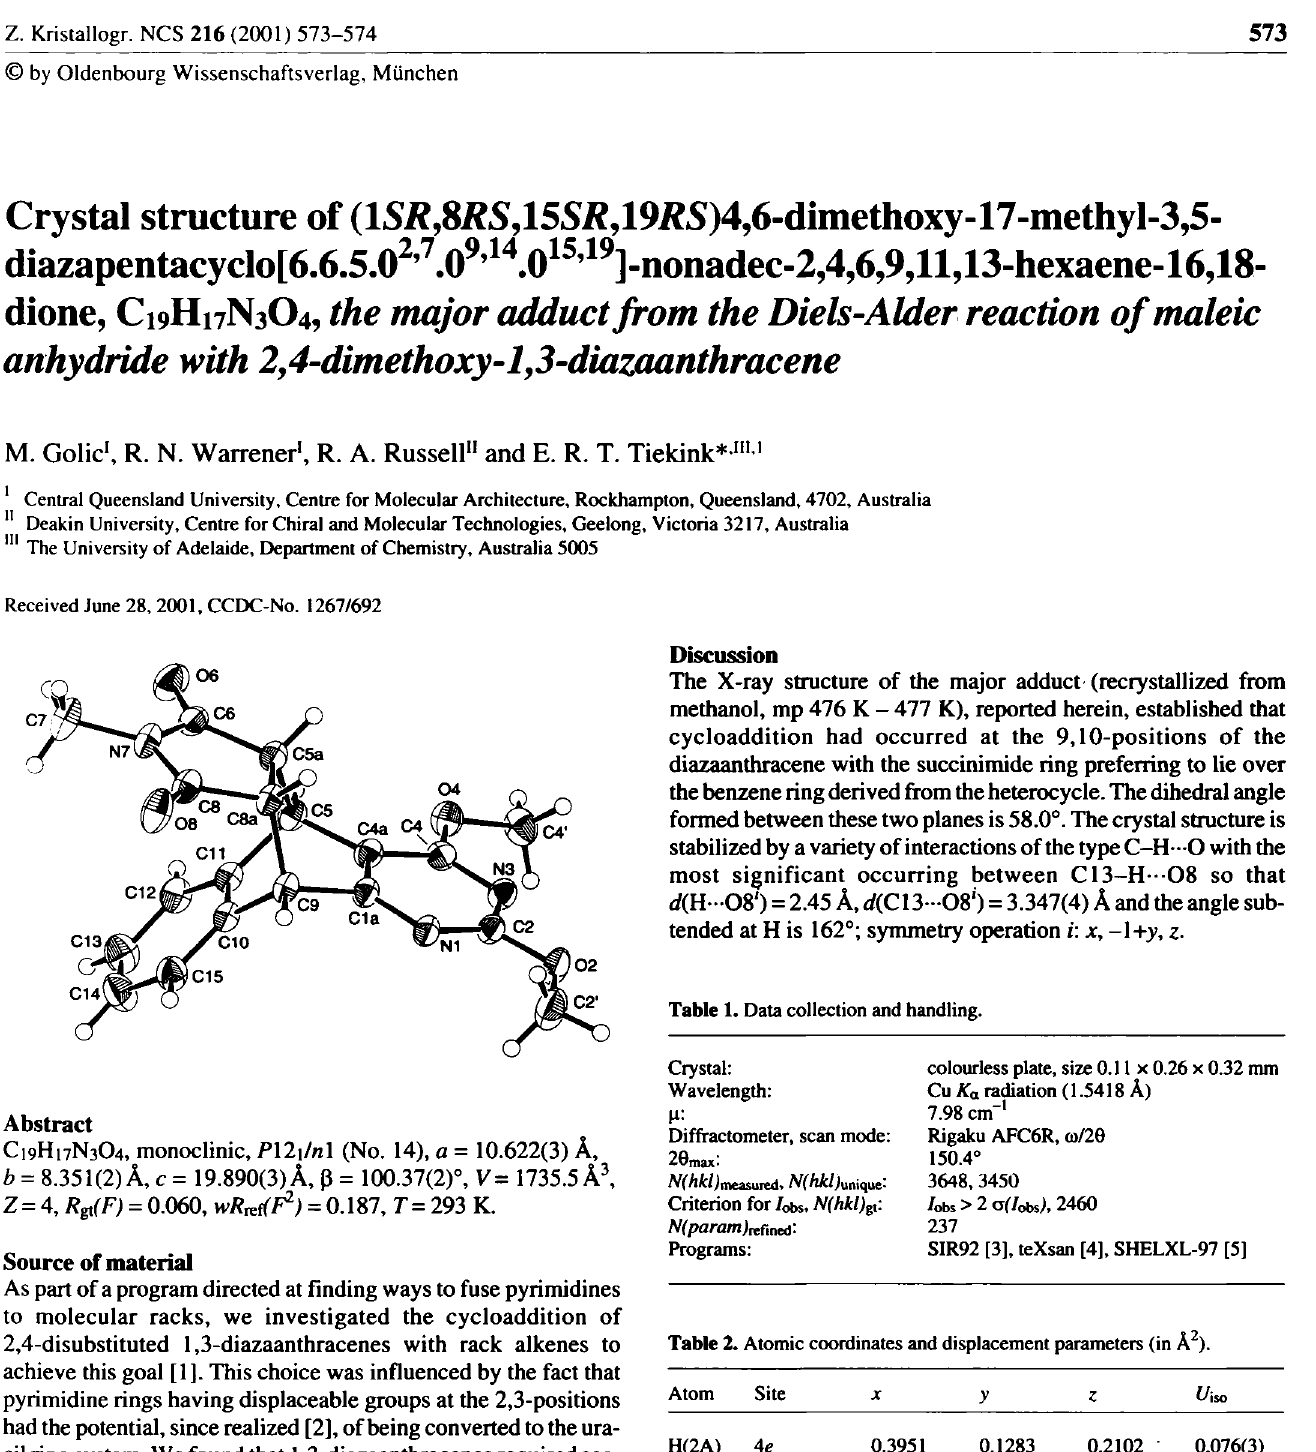
Table 2. Atomic coordinates and displacement parameters (in Ä 2